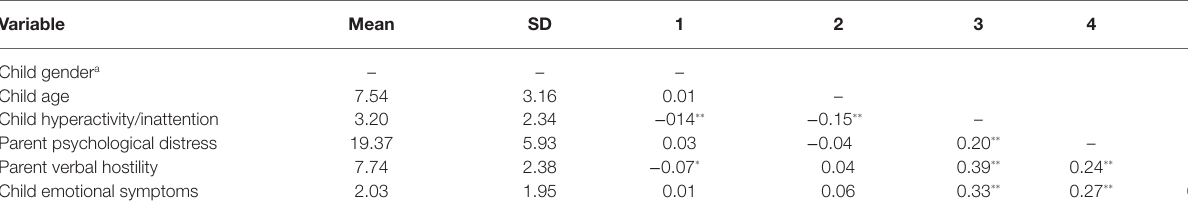
TABLE 2 | Means, standard deviations, and correlations between study variables. Variable Mean SD